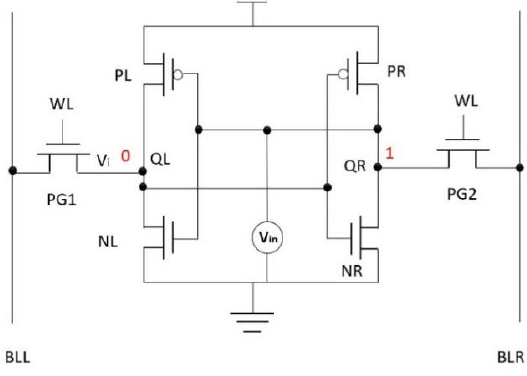
Figure 2. Static stability analysis schematic.